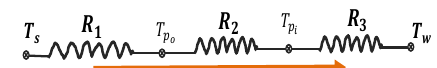
Figure 3: Heat transfer resistance across chilled water